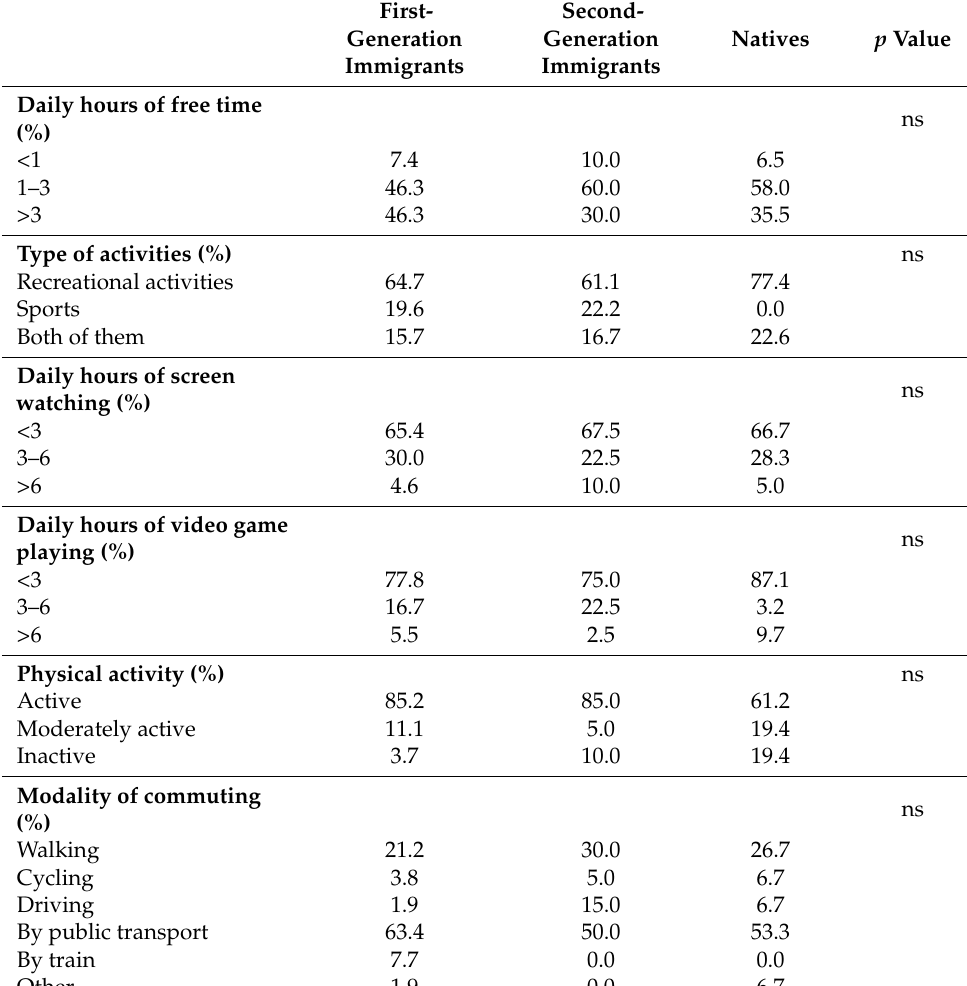
Table 8. Available free time and type of activities, screen time and physical activity, and modality of commuting by migration status.